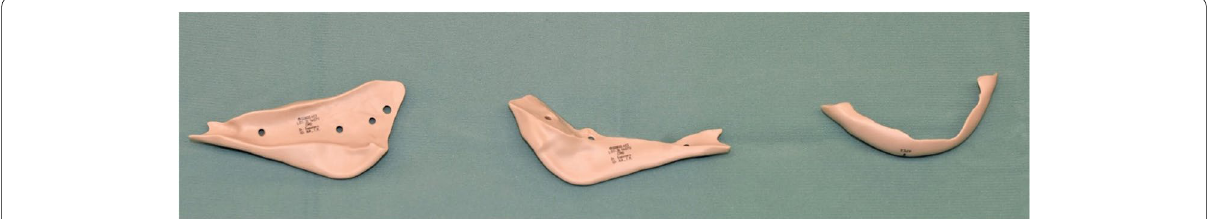
Fig. 6 Three-piece implant designed for a full lower mandibular contour; the three implants have interlocking edges in order to provide the most reliable positioning possible and in order to avoid damage to the mental nerves during